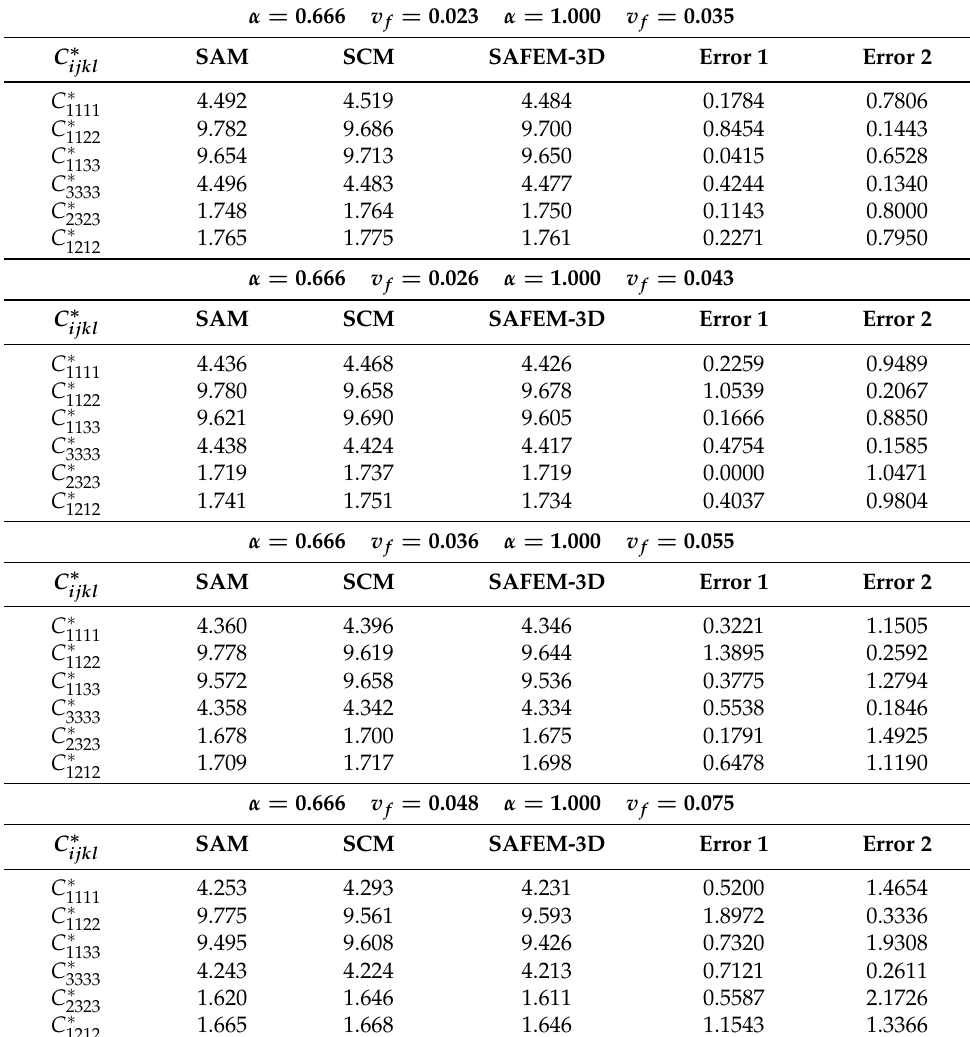
Table 5. Effective elastic coefficients (GPa) for a three-phase FRC reinforced by ellipsoidal and spherical inclusions for different aspect ratios ( α ) and volume fractions ( v f